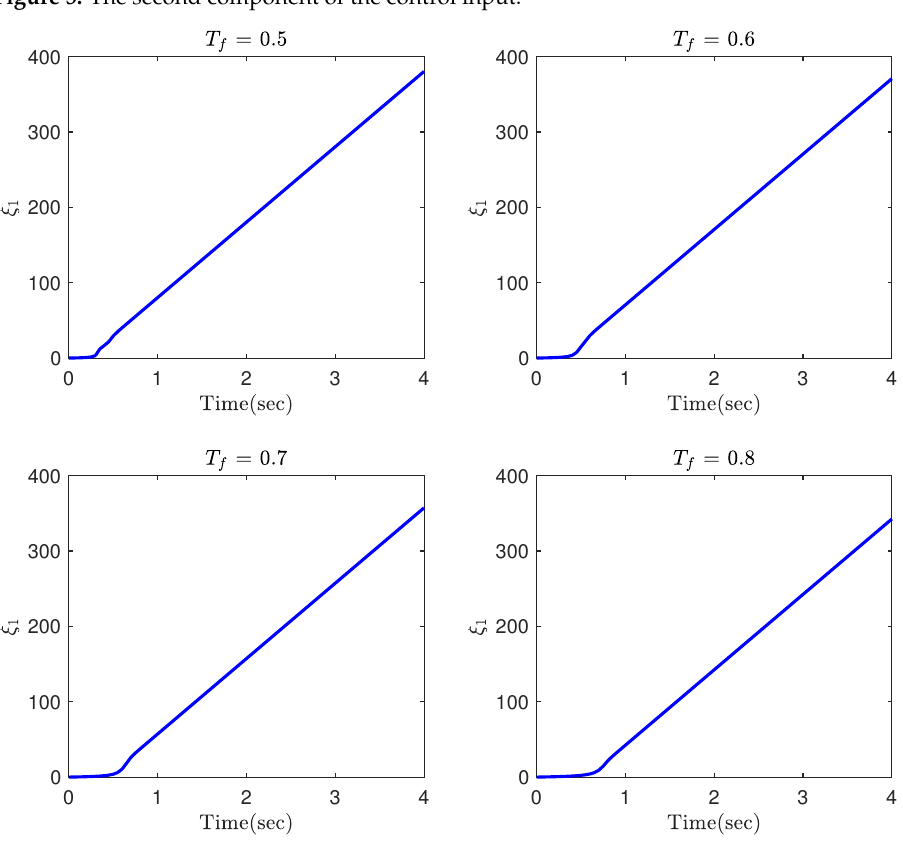
Figure 5. The second component of the control input.